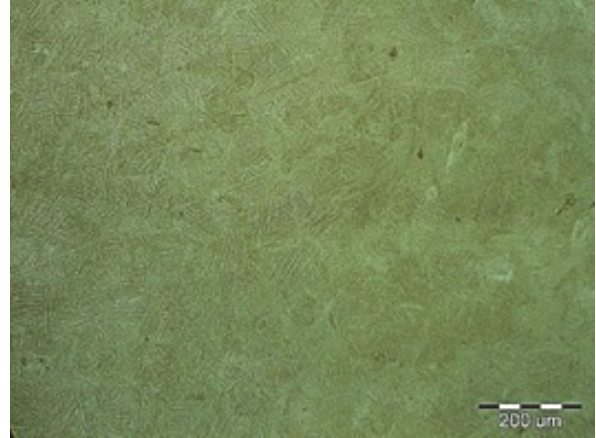
spacing visible in metallographic sections corresponding to the platform lowering by one layer thickness (0.09 µm).